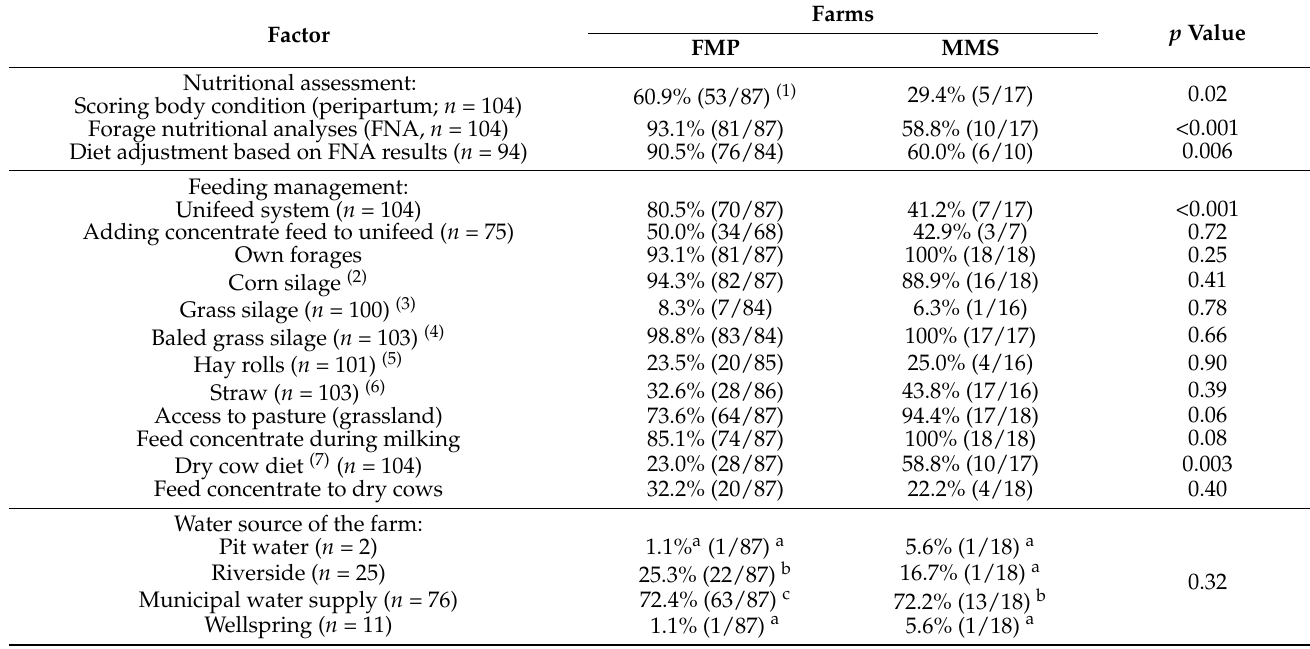
Table 2. Nutritional management and metabolic disease prevention in dairy farms with fixed (FMP) or mobile (MMS) milking